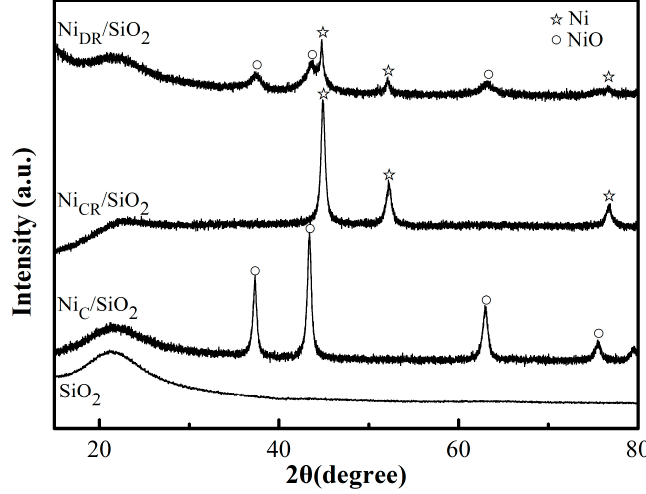
Figure 4. XRD pattern of SiO 2 , Ni C /SiO 2 , Ni CR /SiO 2 and Ni DR /SiO 2 .